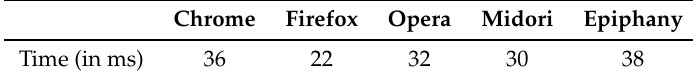
Table 5. Browser performance.